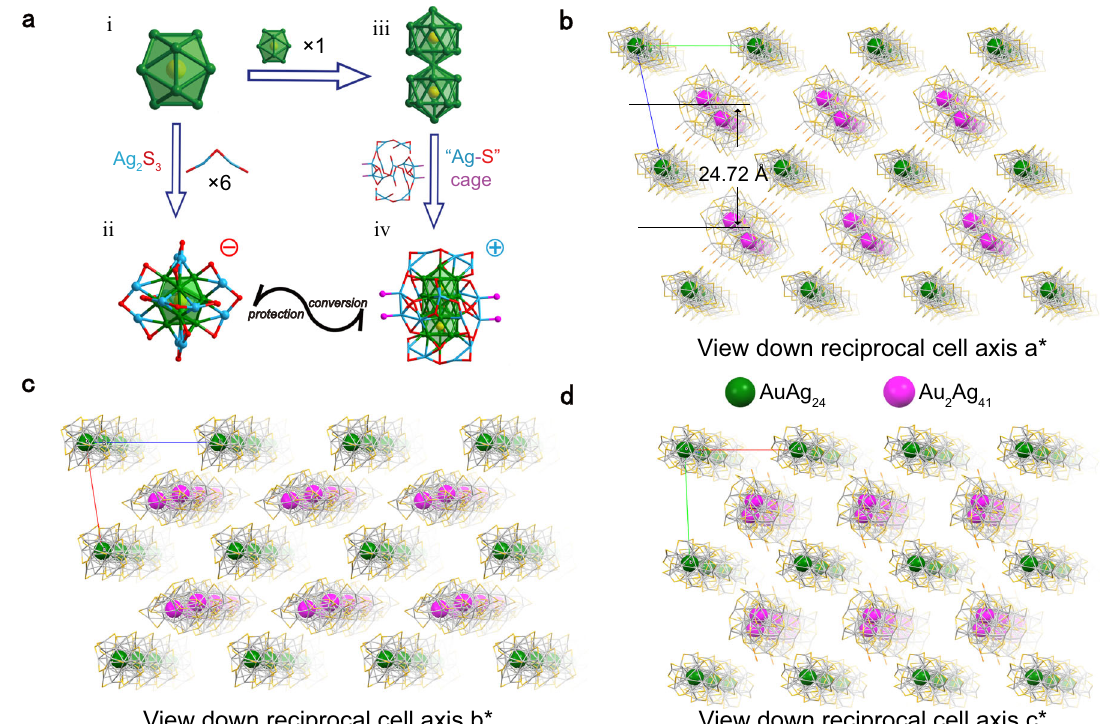
Fig. 2 X-ray structure and packing model of (Au 2 Ag 41 ) ■ (AuAg 24 ) co-crystal. a Detail analysis of AuAg 24 and Au 2 Ag 41 nanocluster. Color labels: yellow, Au; green or sky blue, Ag; red, S; fuchsia, P. All C and H atoms are omitted for clarity; b , c , and d view down reciprocal cell axis a*, b*, and c*, respectively. The interlayer distance is 24.72 Å. The packing mode of (Au 2 Ag 41 ) ■ (AuAg 24 ) shows that this is a lamellar co-crystallization system. All H and C atoms are omitted for clarity. To highlight, the gold atoms in AuAg 24 and Au 2 Ag 41 are highlighted in green and pink,